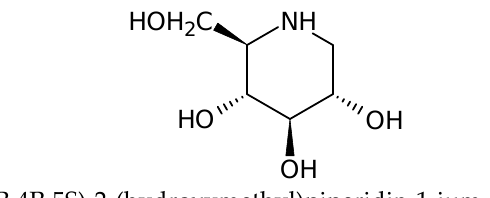
Figure 1. Structure of 1-deoxynojirimycin (DNJ).